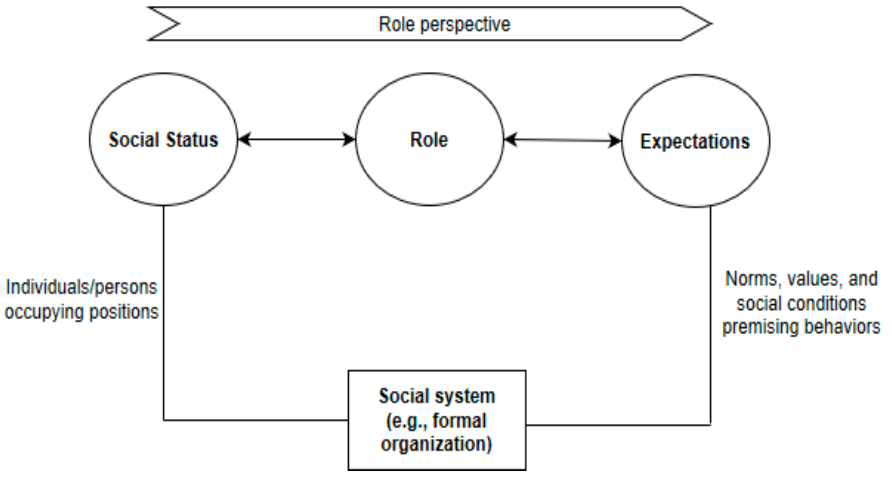
Figure 2. Social status, role, and expectations.